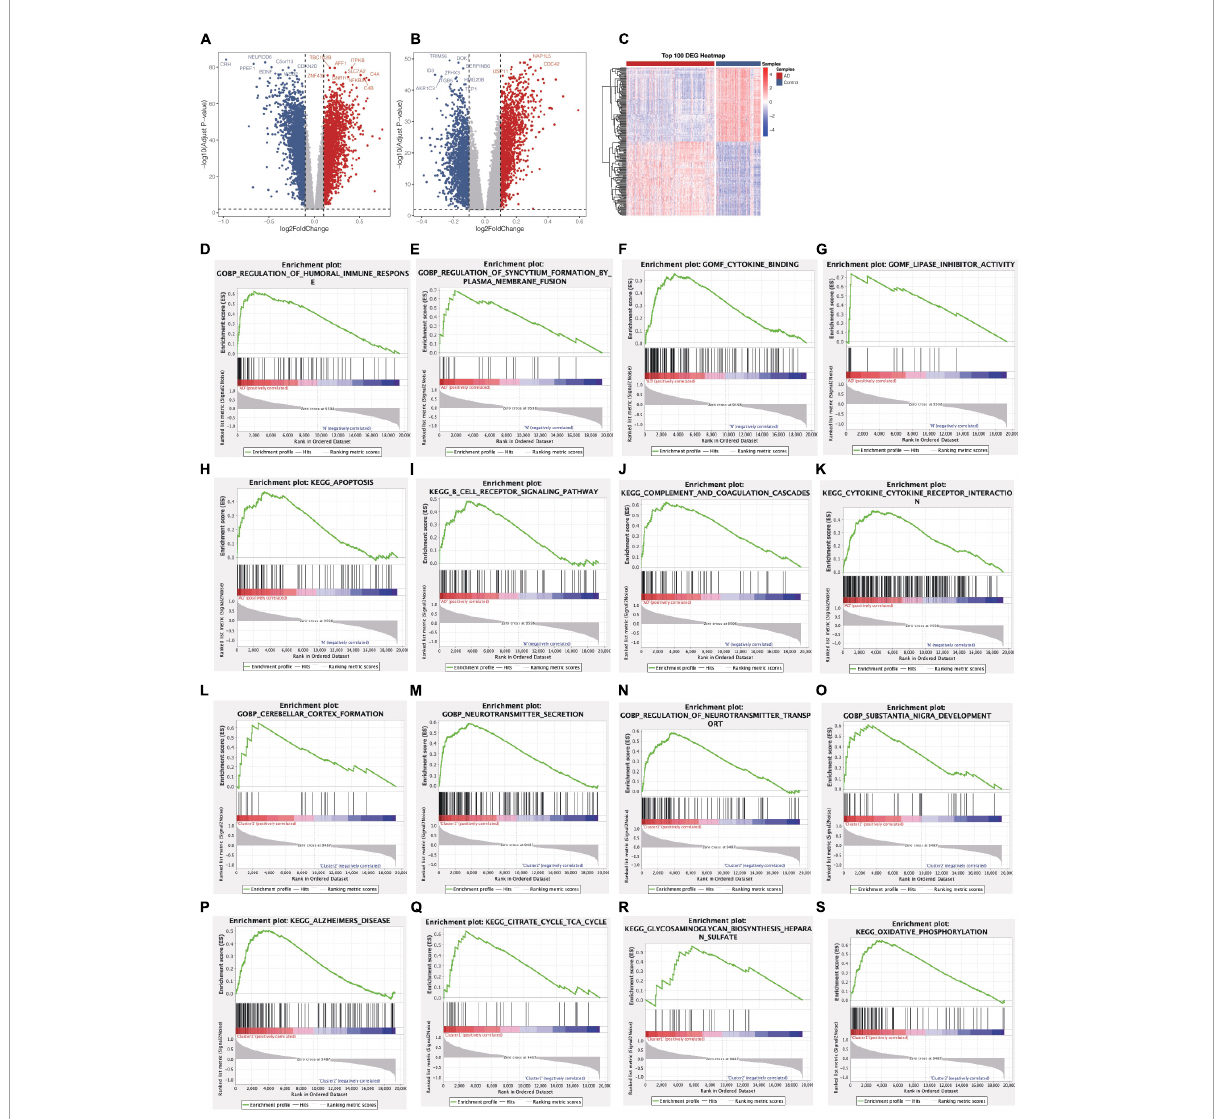
FIGURE3 Identification of DEGs and Gene Set Enrichment Analysis from two groups. (A) Volcano plot of DEGs between AD patients and control samples (AD vs Normal). (B) Volcano plot of DEGs between Cluster1 and Cluster2 (Cluster1 vs Cluster2). (C) A heatmap of the top 100 DEGs. (D–K) Biological functions and pathways of genes between AD and normal samples. (L–S) Biological functions and pathways of genes between cluster1 and cluster2.